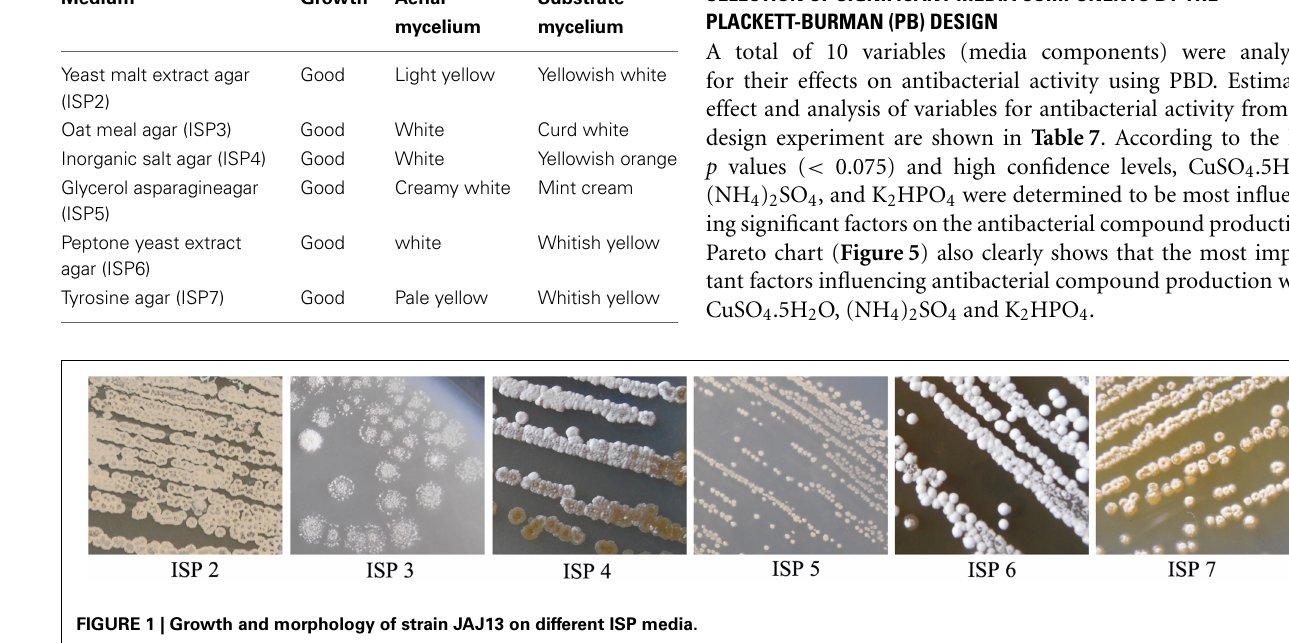
FIGURE 1 | Growth and morphology of strain JAJ13 on different ISP